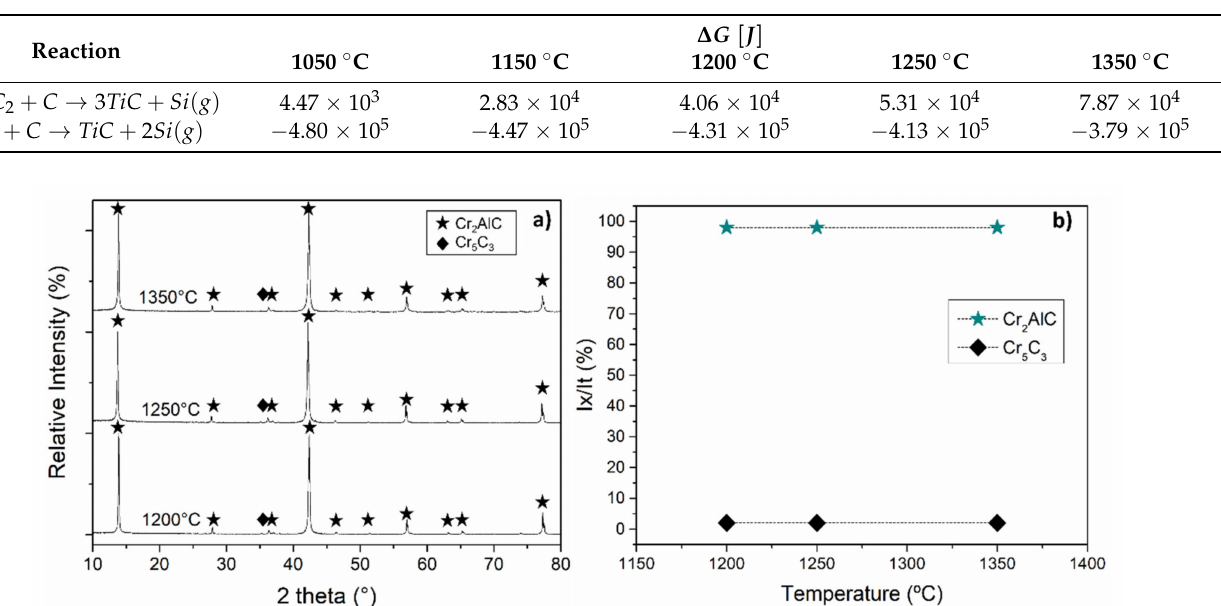
Figure 4. ( a ) The X-ray diffraction patterns of hot-pressed Ti 3 SiC 2 powders from 1050 ◦ C to 1350 ◦ C and ( b ) the phase evolution from the XRD profiles. Table 2. The Gibbs free energy calculations of different possible reactions during the hot pressing process at temperatures ranging from 1050 ◦ C to 1350 ◦ C.